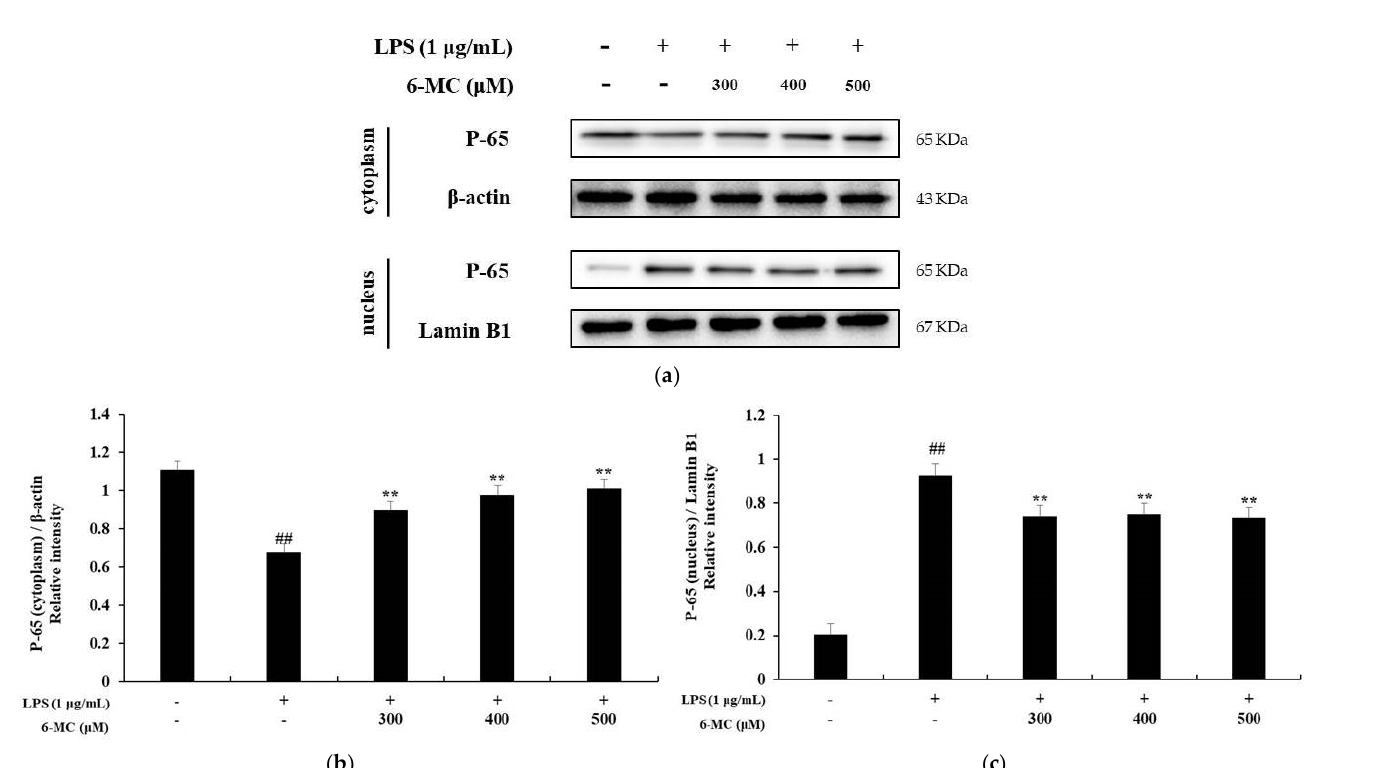
Figure 8. Effect of 6-MC on the protein expression level of NF-κB (P-65; cytoplasm) and (P-65; nucleus) in LPS-induced RAW 264.7 cells. ( a ) Result of Western blotting, and protein level of ( b ) P-65 (cytoplasm) and ( c ) P-65 (nucleus). Lysates were prepared from cells pretreated with 6-MC (300, 400, and 500 μM) for 1 h and then treated with LPS (1 μg/mL) for 15 min. β-actin and Lamin B1 were used as a loading control. Total cellular proteins were separated using SDS-PAGE, transferred to PVDF membranes, and detected using specific antibodies against NF-κB/P-65, Lamin B1, and β-actin. The results in the graphs are presented as the mean ± SD from three independent measurements using the ImageJ program. ## p < 0.01 vs. untreated control group. ** p < 0.01 versus group treated with LPS alone.